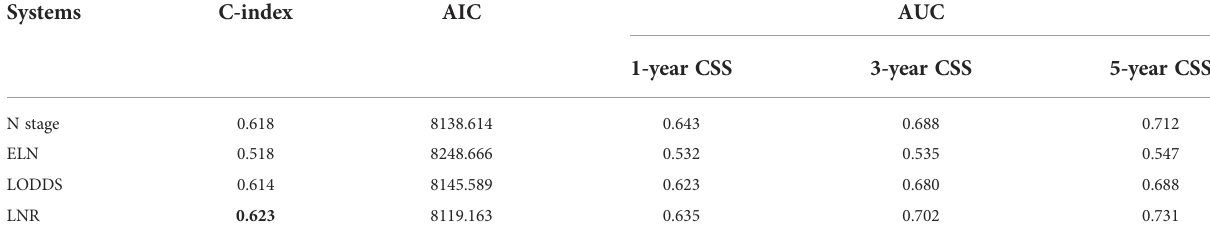
TABLE 3 Prognostic ef fi ciency of different lymph node staging systems. Systems